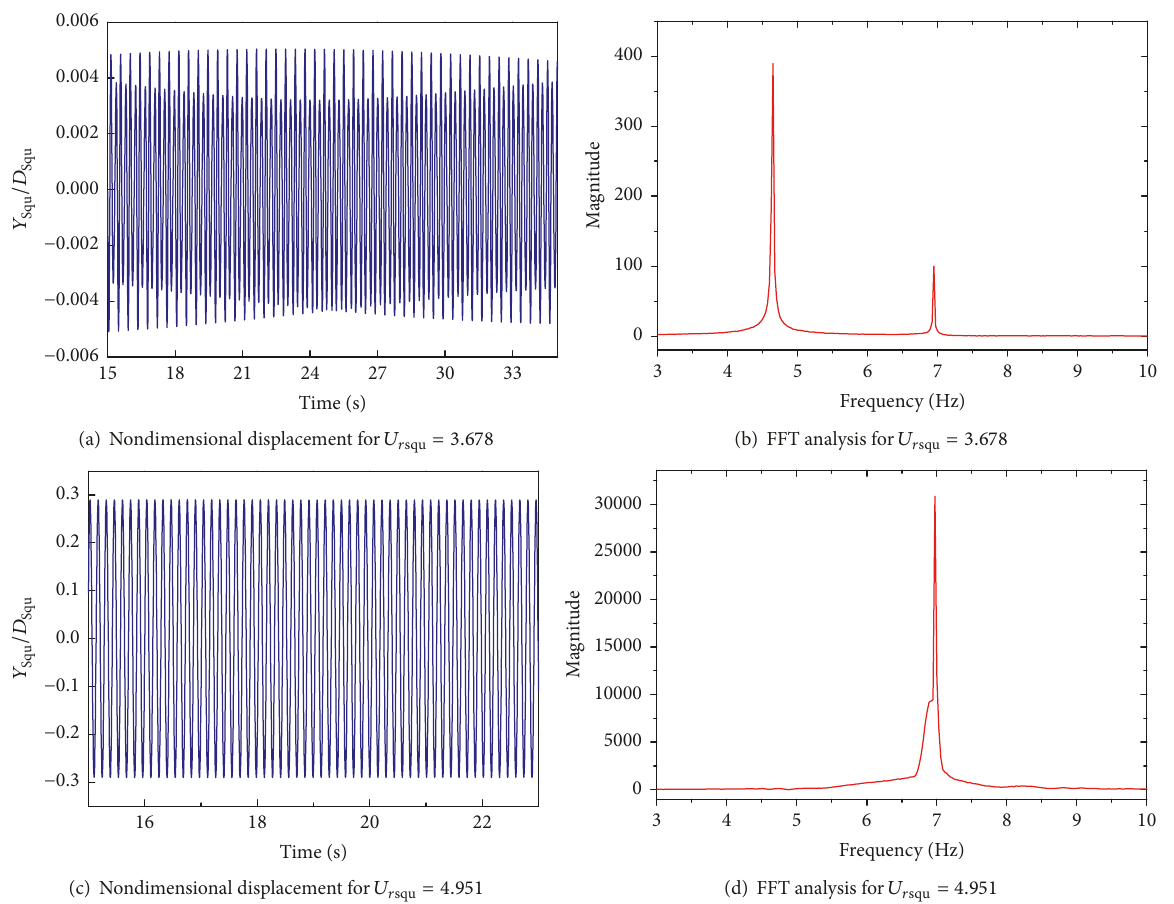
Figure 8: Displacement time-history and FFT analysis results for 𝛼 = 45 ∘